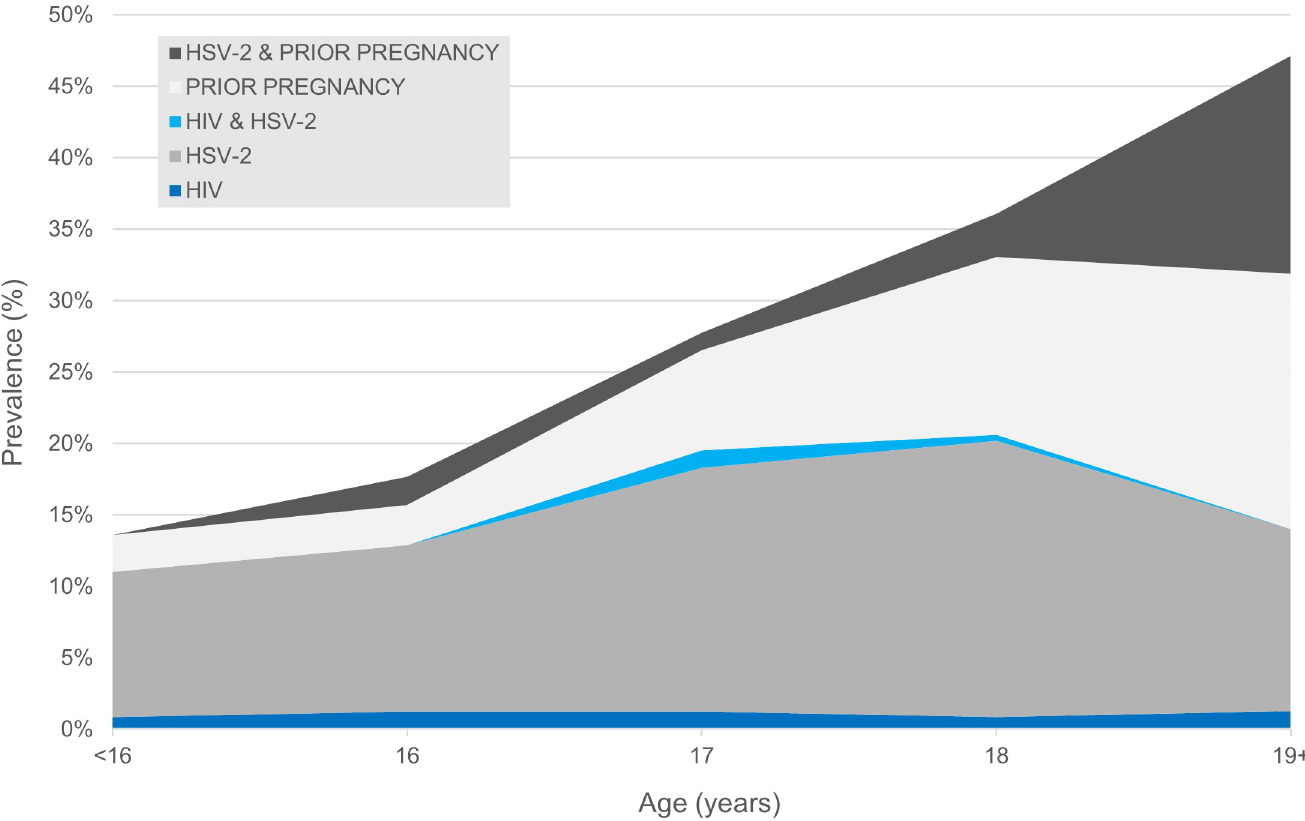
Fig 3. Combined baseline prevalence of HIV, HSV-2, and history of pregnancy among sexually active CCG girls ( n = 1,090). CCG, Cups or Cash for Girls Trial; HIV, human immunodeficiency virus; HSV-2, herpes simplex virus type 2.